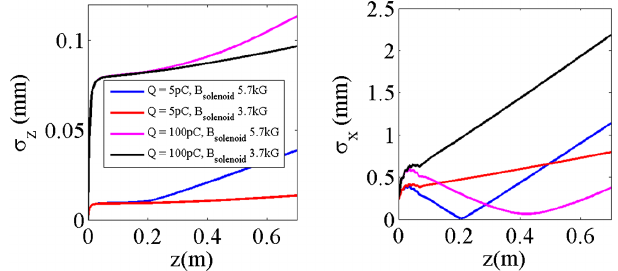
FIG. 19. Simulated bunch lengthening (a) in the drift region after the gun for different bunch charges and densities assuming a laser pulse having a 0.5 mm spot radius and 100 fs FWHM Gaussian longitudinal distribution. Two charge densities were simulated by changing the gun solenoid focusing strength. (b) The corresponding rms transverse beam